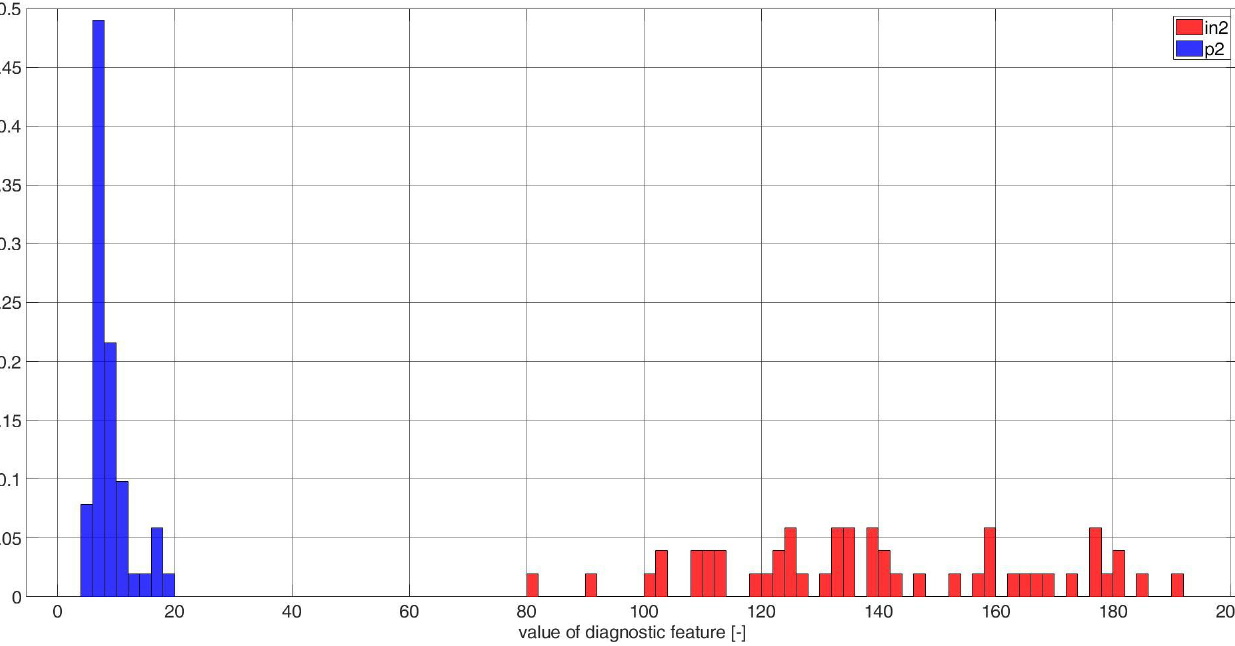
Figure A4. Histograms of diagnostic features based on the CCSM3 (correlation number is 5 — Table A1) bearings in2 and p2.